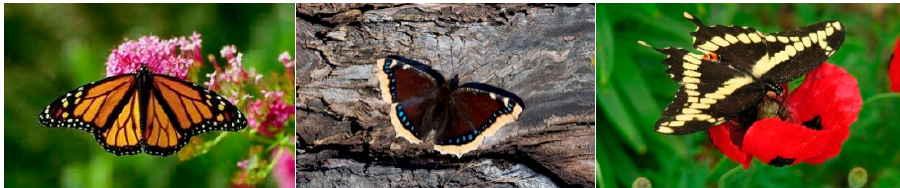
Figure 2. Sample images of 10 categories in the Leeds Butterfly Dataset.